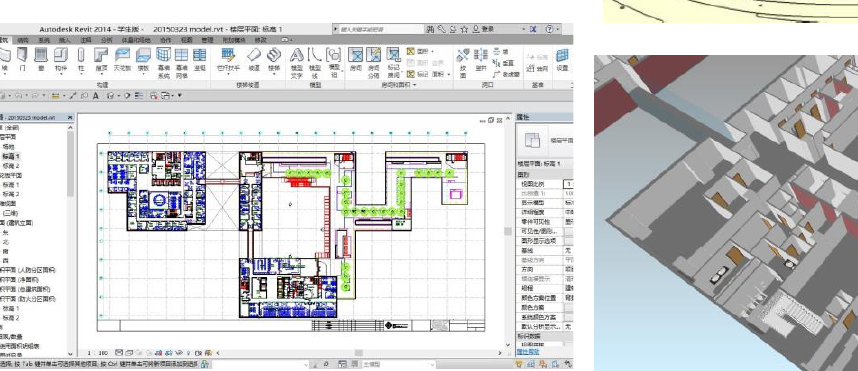
Figure 2. Floor plan of the test site